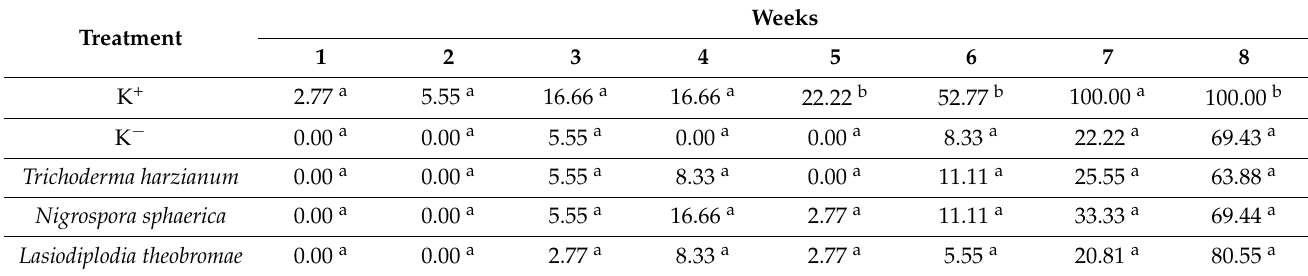
Table 3. Incidence of Fusarium Wilt on Banana Plant Leaves 1–8 Weeks after Inoculation (%). Treatment